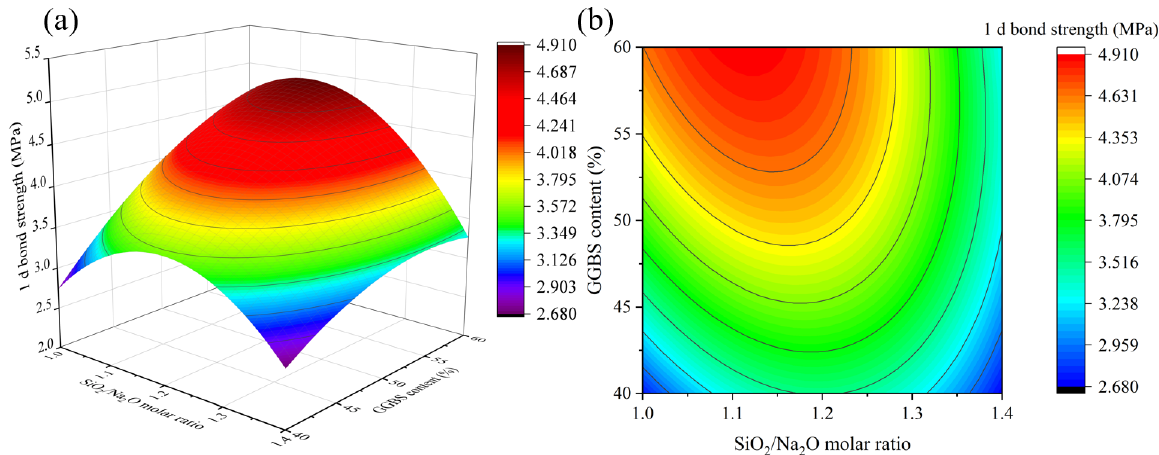
Figure 14. The interaction effect of SiO 2 /Na 2 O molar ratio and GGBS content on 1 d bond strength: ( a ) 3D response surface; ( b ) contour diagram.